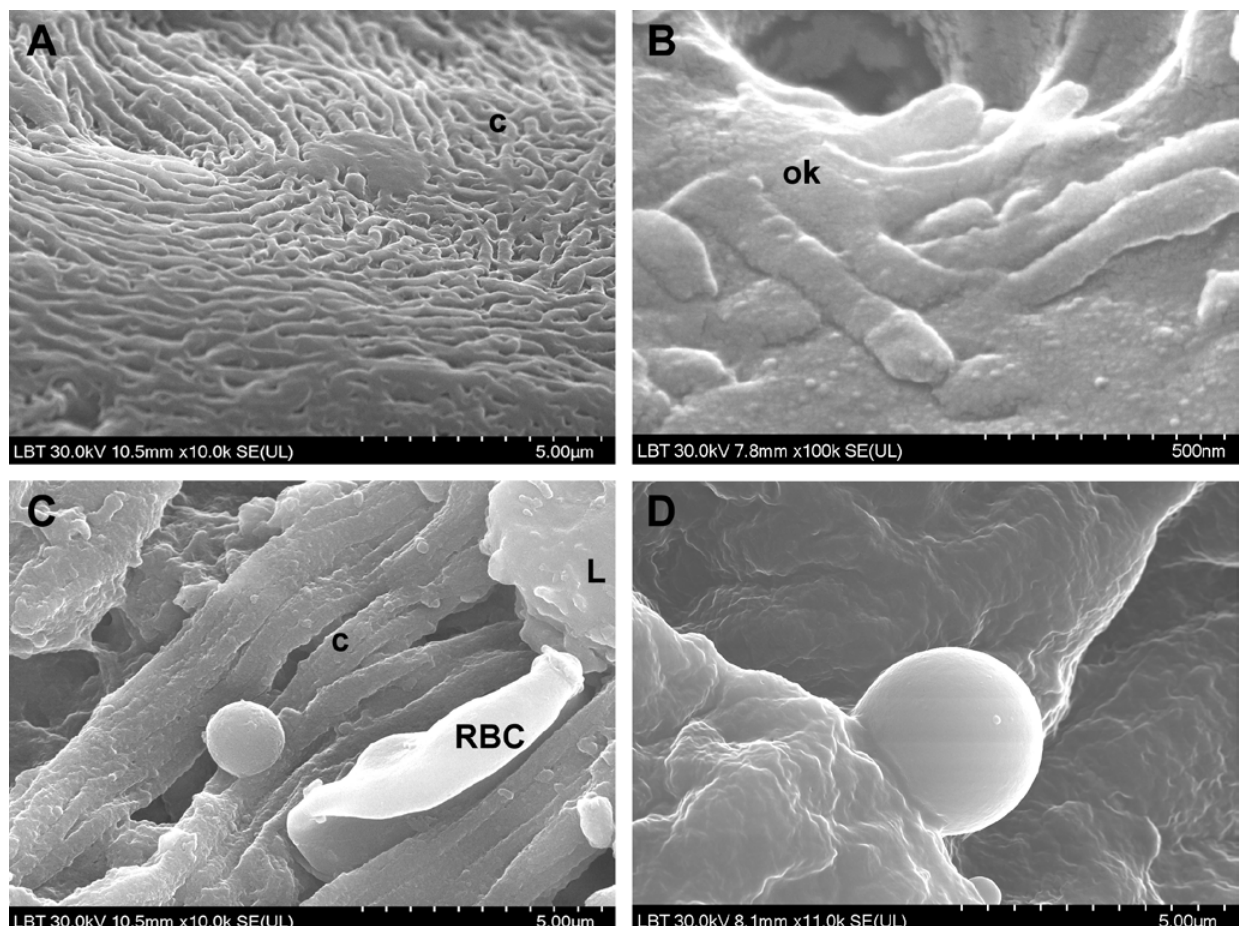
Figure 5. Surface of the nasal mucosa in control samples (scanning electron microscopy): ( A )—cilia; ( B )—olfactory cilia; ( C )—rare microbial elements; ( D )—smooth leukocytes (c—cilia, ok—olfactory knob, RBC—red blood cell, L—leukocyte).